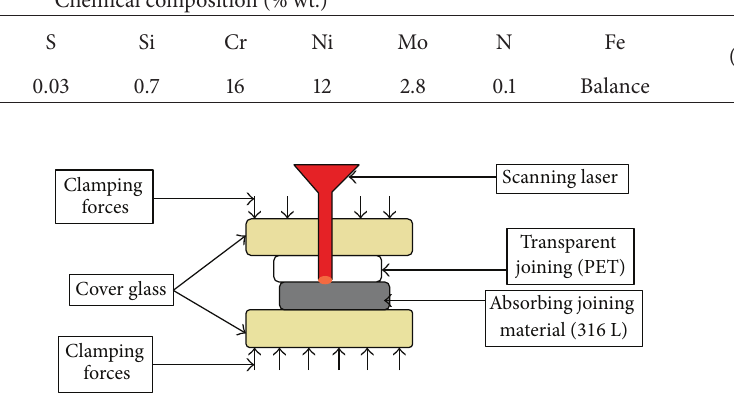
Table 1: Chemical composition and mechanical properties of 316 L stainless steel (% wt.). Chemical composition (% wt.)